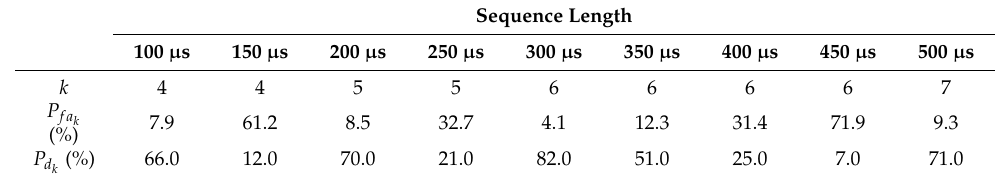
Table 1. Correct ranging probability ( P d ) when the detected signal codes number equals the signal k recognition threshold ( i = k ) and incorrect ranging probability ( P fa ) when the detected noise codes number k is equal to or greater than the signal recognition threshold ( i n ≥ k ) under different sequence lengths.